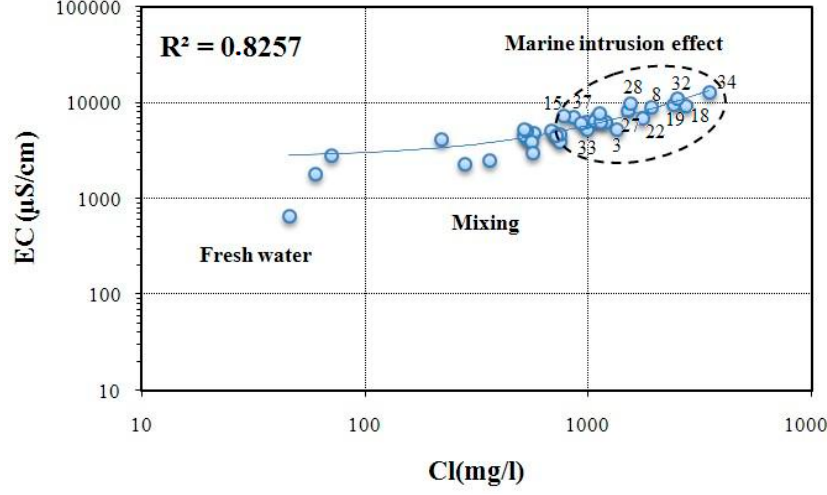
Figure 11. EC vs. Cl plot in the study area.